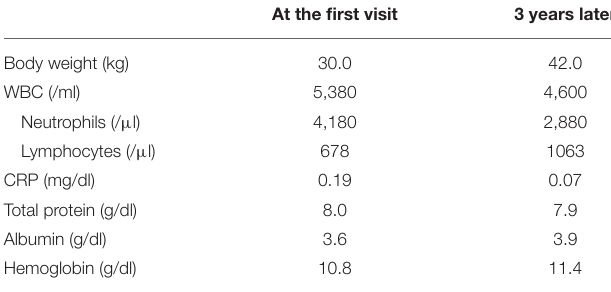
TABLE 1 | Laboratory data before and after bukuryoshigyakuto